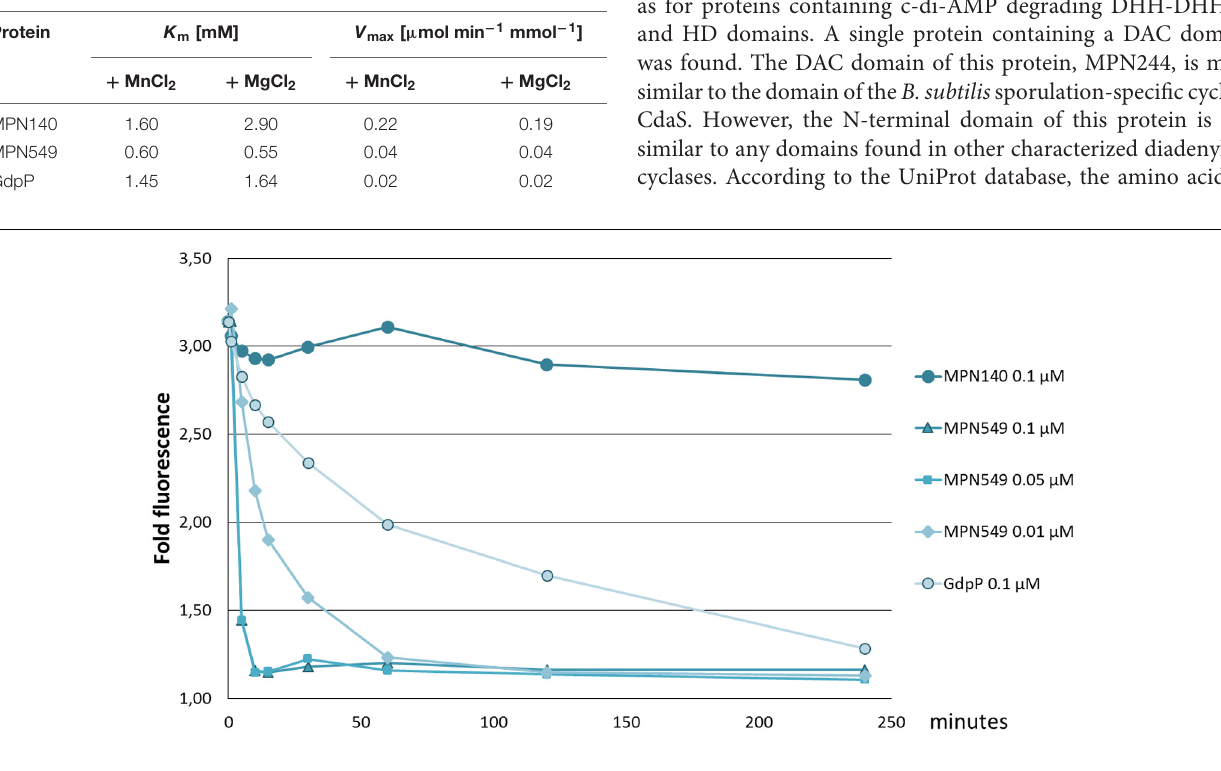
Frontiers in Microbiology |